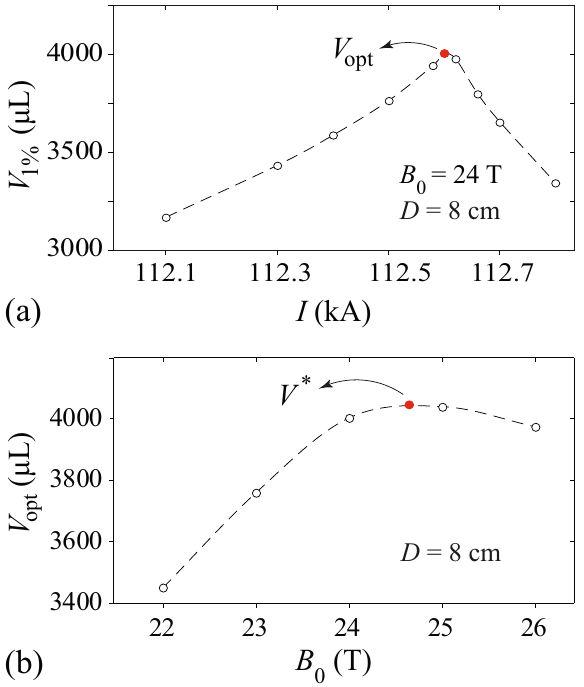
Fig. 3 Optimization analysis of the functional volume of our MLS design. a Calculated V 1% versus the loop current I for the coil shown in Fig. 2 with B 0 = 24 T. The largest V 1% is denoted as V opt . b The obtained V opt as a function of B 0 . The overall maximum V opt is denoted as V * , and the corresponding coil current and base fi eld are , designated as I * and B (cid:4) 0